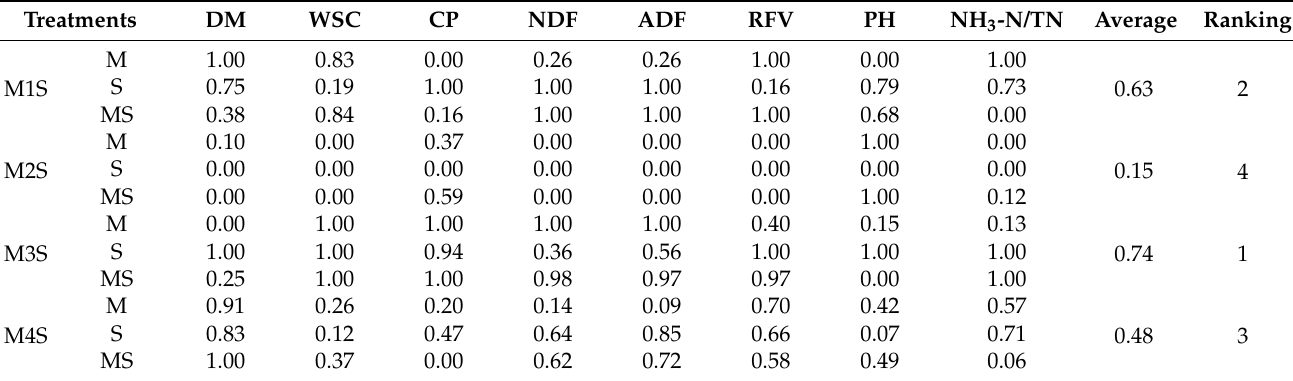
Table 7. Membership function analysis of silage